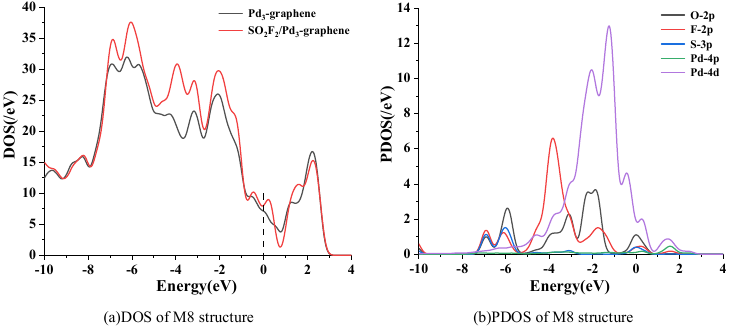
Figure 9. Density of states (DOS) and partial density of states (PDOS) of system M8. Dashed line represents the Fermi level.